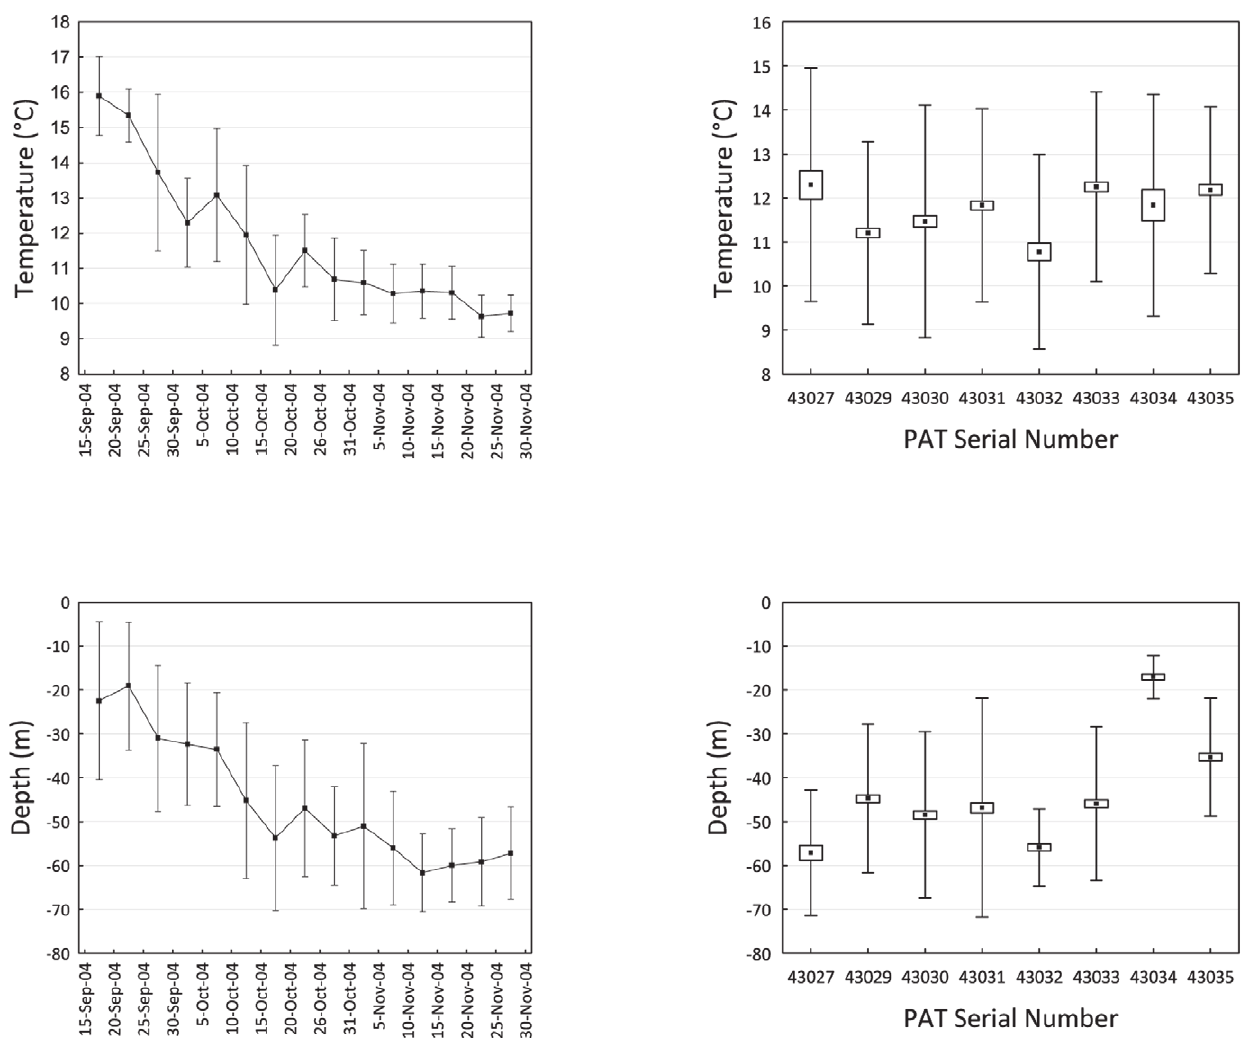
Figure 5. Temperature and Depth Summaries for PATs. Mean temperature and depth for eight green sturgeon fitted with pop-off archival tags (PAT) by date (left panels) and by individual sturgeon (right panels). Data points in the left panels indicate 5-day moving averages with standard deviations (whiskers). Data points in the right panels indicate means, bars denote 95% confidence intervals about the mean, and whiskers specify standard deviations.